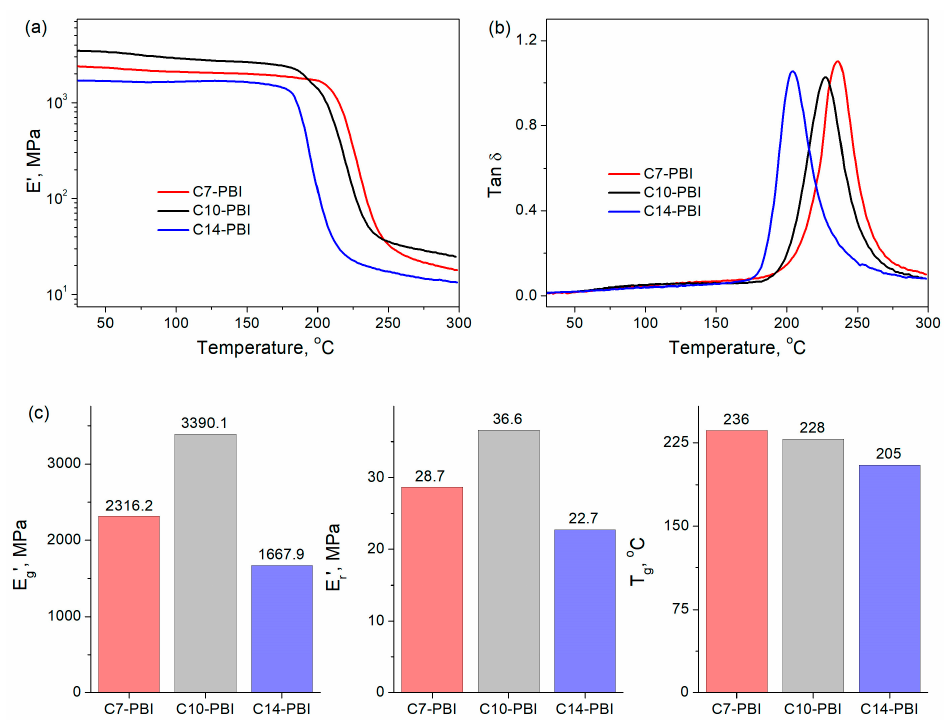
Figure 4. Temperature dependence of storage modulus E’ ( a ) and Tan δ ( b ) of PBIs according to DMA. Summary of E g ’, E r ’ and T g of PBIs ( c